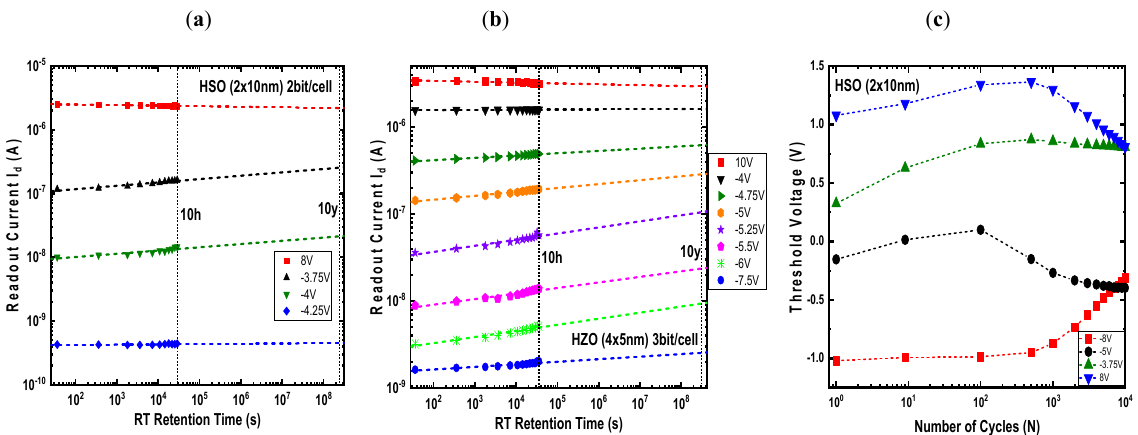
Figure 15. The laminate FeFET MLC retention for ( a ) the HSO 2 bit/cell and ( b ) the HZO 3 bit/cell measured to 10 h (RT) and extrapolated for the 10 years criterion, ( c ) The laminate MLC endurance (2 bit/cell) with 10 4 cycles shows V T degradation due to charge trapping. Reproduced with permission from [17] T. Ali et al., IEDM; published by IEEE, Copyright 2019, IEEE.